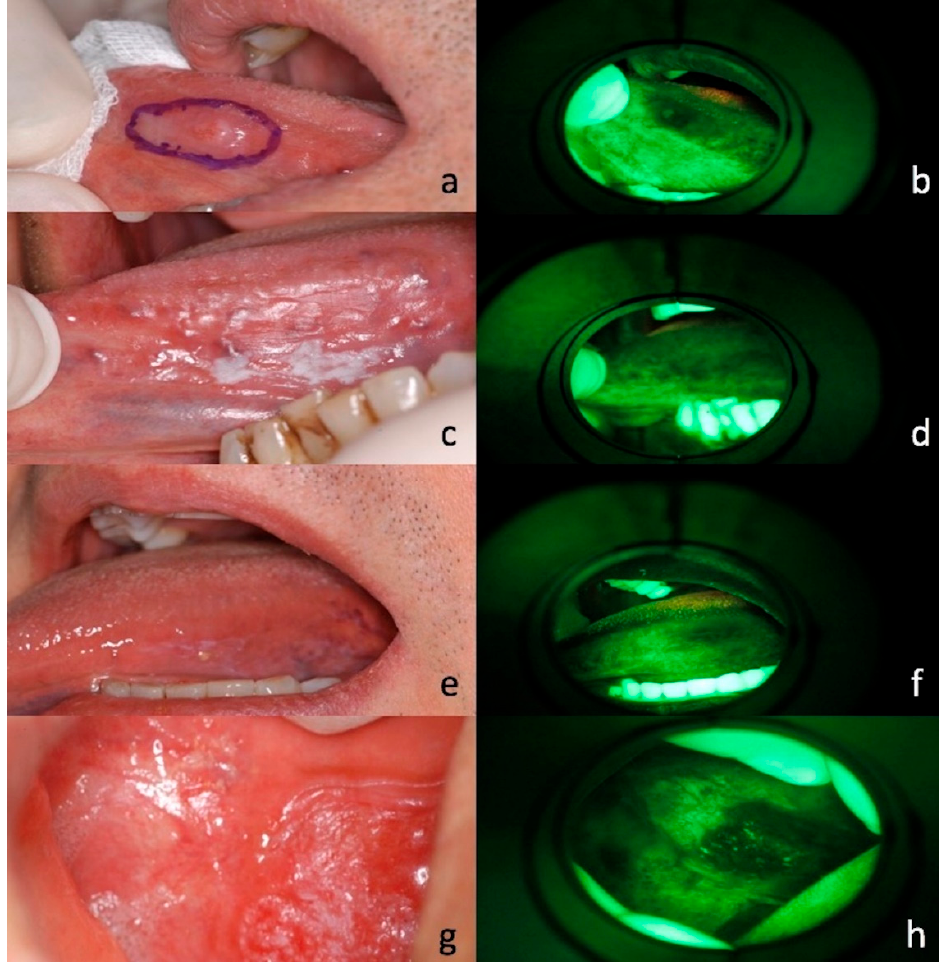
Figure 3. Clinical appearance of the painful suspected lesion on the right buccal mucosa in a 63-year- old female smoker patient and appearance of the VelScope exam of the same lesion characterized by LAF and associated red/orange coloring typical of secondary bacterial